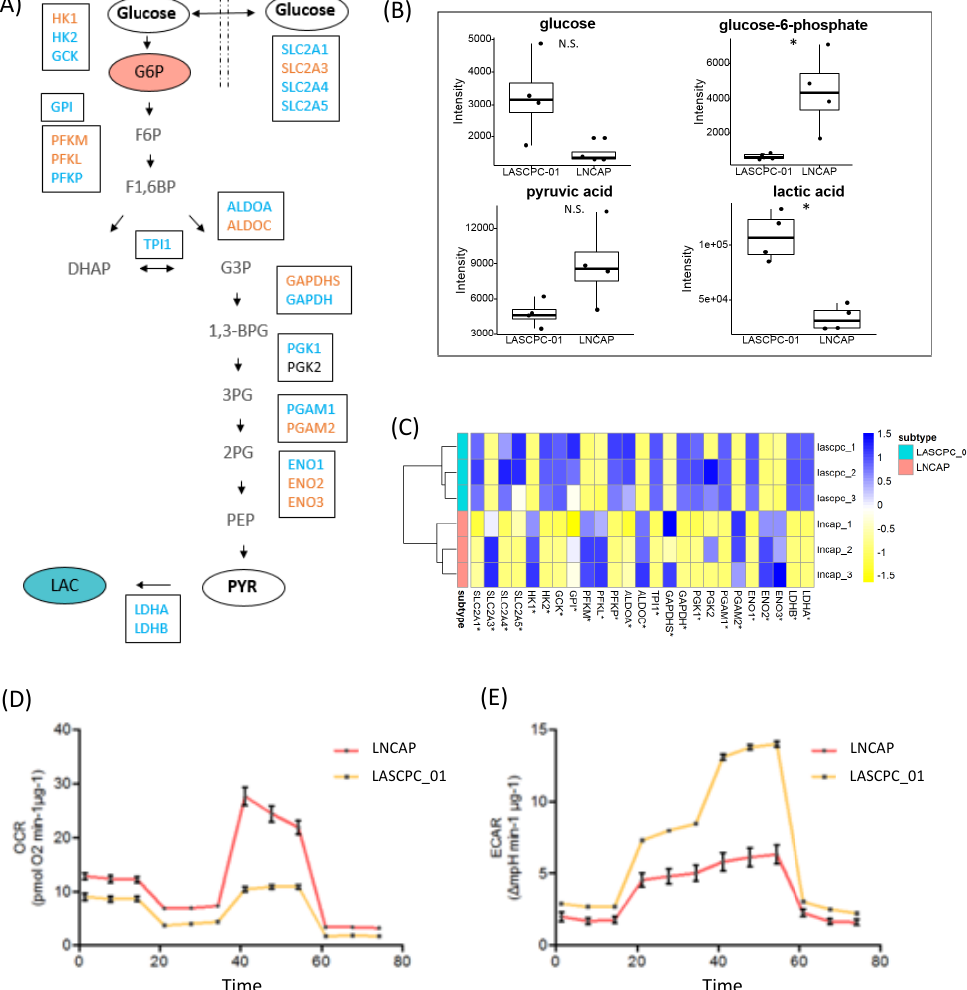
Figure 4. Glycolytic activity of two cell lines. ( A ) Metabolites and genes involved in the glycolysis pathway. Blue: higher in LASCPC-01; Orange: higher in LNCAP; Bold: no significant di ff erence; Grey: not detected. ( B ) Detected metabolites involved in the glycolysis process. N.S.: no significant di ff erence; *: p < 0.05. ( C ) Detected transcripts involved in glycolysis; *: p < 0.05. ( D ) Oxygen consumption rate of two cell lines. ( E ) Extracellular acidification rate of two cell lines.